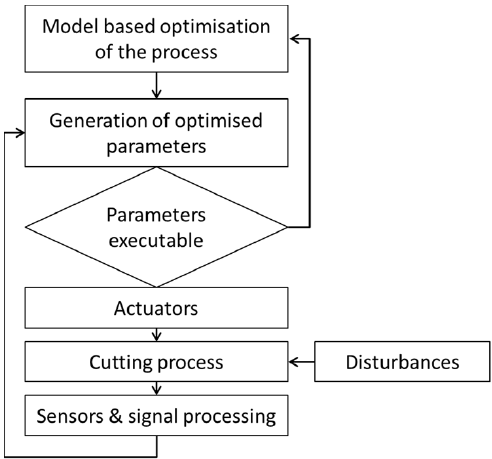
Figure 2. Cutting process optimization.